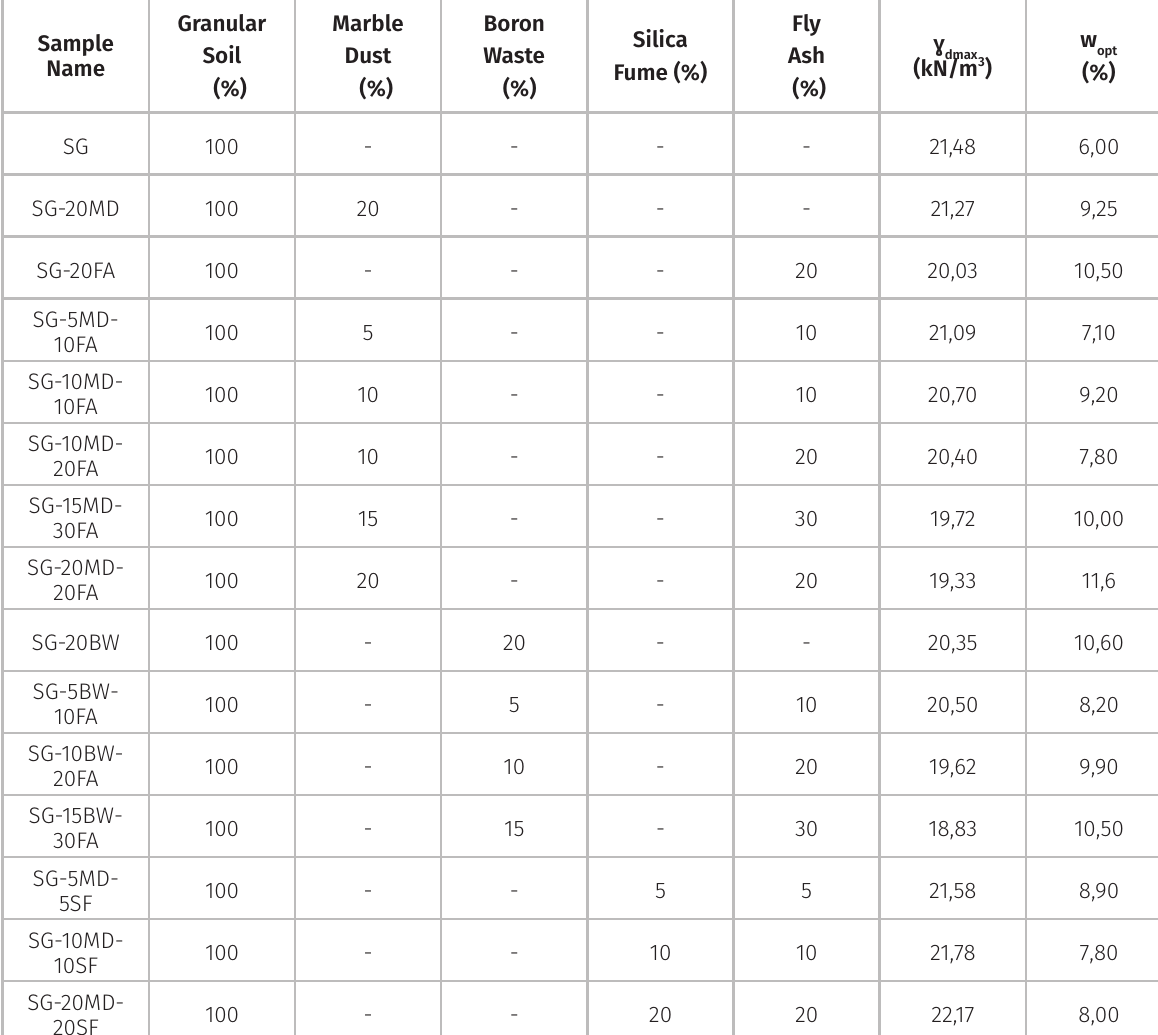
Table II. The mixture ratios and compaction parameters of